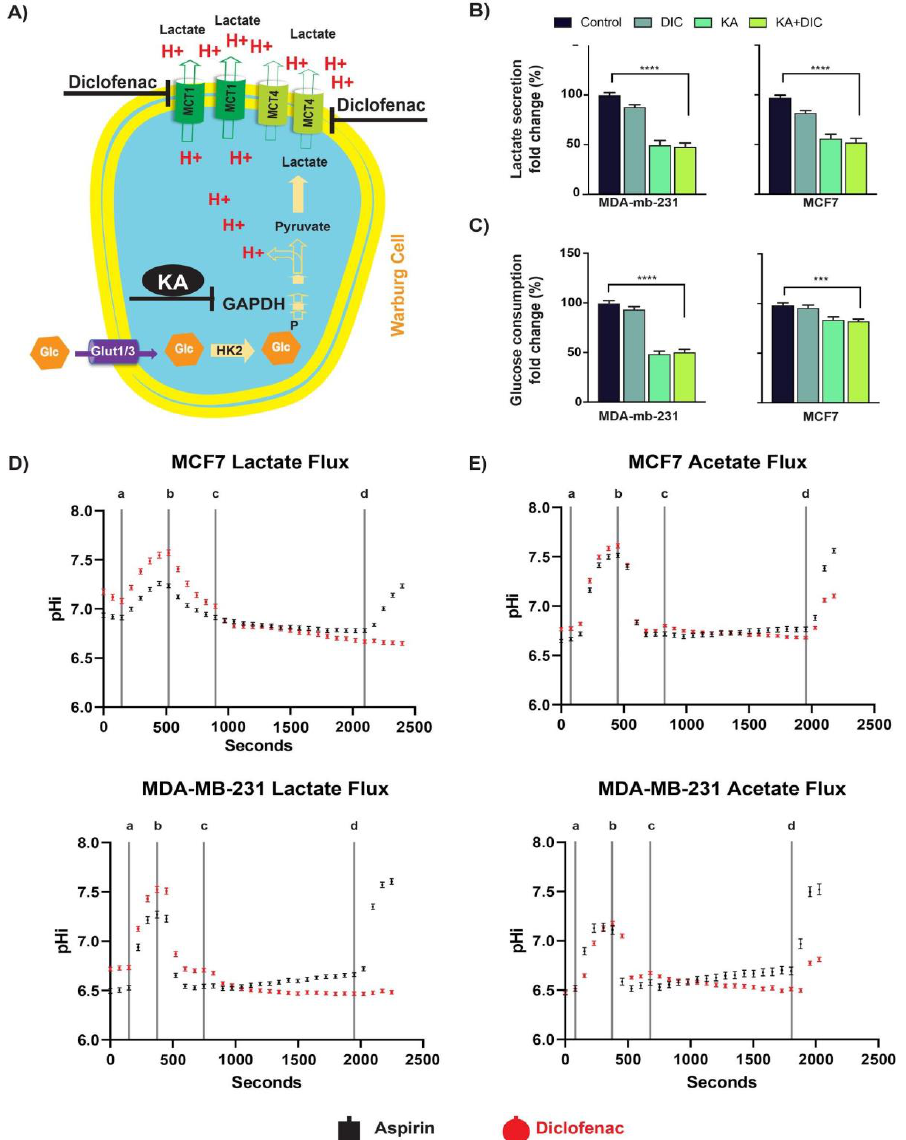
Figure 1. Diclofenac and koningic acid reduce the glycolytic activity of cancer cells. ( A ) Schematic showing effect of Diclofenac (1 µ M) to reduces the activity of MCT transporters leading to acidification of the intracellular pHi. Koningic acid (KA) reduces glycolytic activity by inhibiting GAPDH that has an alkaline pH optimum. ( B ) Lactate production was reduced in both MCF7 and MDA-MB-231 cells after treatment with diclofenac, KA, or both. ( C ) Glucose consumption was reduced in both MCF7 and MDA-MB-231 cells after treatment with diclofenac, KA, or both. ( D ) MCF7 and MDA-MB-231 cells were treated with diclofenac or Aspirin to measure the effect of drug on their lactate transport abilities. Line (a) represents the switch from a 30 mM lactate environment to a 0 mM Lactate environment. Line (b) represents the switch from a 0 mM lactate environment to a 30 mM lactate environment. Line (c) represents the switch from a 30 mM lactate environment − drug treatment to a 30 mM lactate environment + drug treatment. Line (d) represents the switch from a 30 mM lactate environment + drug treatment to a 0 mM lactate environment + drug treatment. ( E ) MCF7 and MDA-MB-231 cells were treated with diclofenac or Aspirin to measure the effect of drug on their pHi altering effects. Line (a) represents the switch from a 30 mM acetate environment to a 0 mM acetate environment. Line (b) represents the switch from a 0 mM acetate environment to a 30 mM acetate environment. Line (c) represents the switch from a 30 mM acetate environment − drug treatment to a 30 mM acetate environment + drug treatment. Line (d) represents the switch from a 30 mM acetate environment + drug treatment to a 0 mM acetate environment + drug treatment. p -values are represented as follows: *** p < 0.001, **** p <